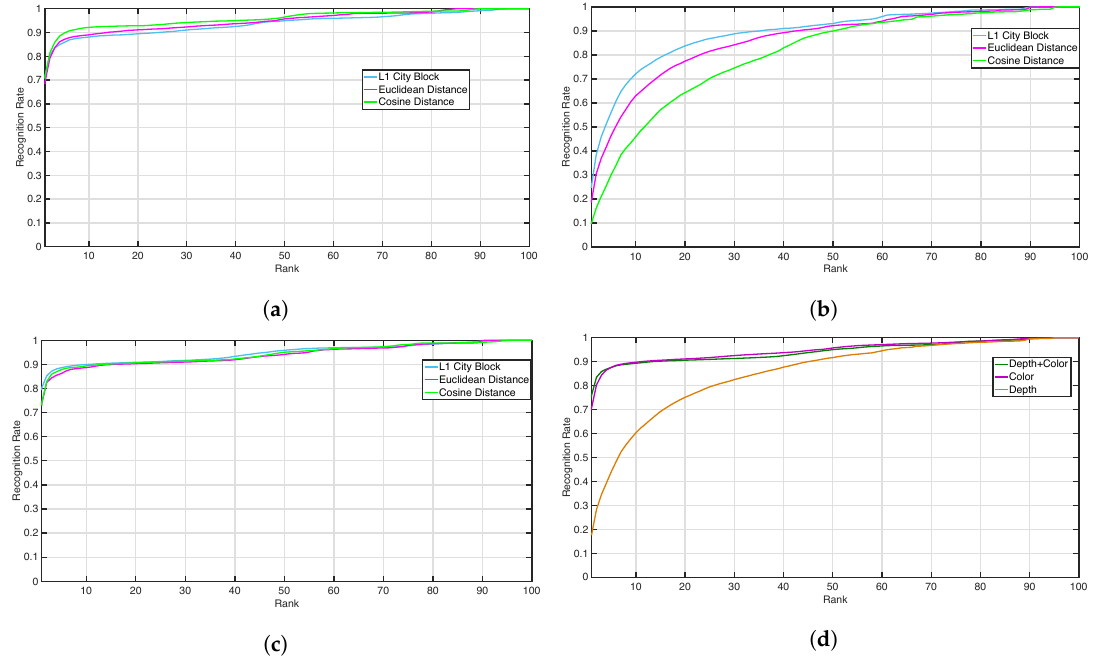
Figure 5. The baseline Cumulative Matching Curve (CMC) curves obtained on the Top View Person Re-Identification (TVPR) dataset. ( a , b ) shows respectively the CMC obtained using the TVH and TVD descriptors for three different distance: one-norm (L1 city block, cyan), two-norm (euclidean, purple) and cosine (green). ( c ) provides the CMC computed using both the TVH and TVD descriptors (i.e., TVDH ), while ( d ) is the averaged CMC over the three considered distance for the color (i.e., average of CMC curves in (a), purple), depth (i.e., average of CMC curves in (b), orange) and depth + color (i.e., average of CMC curves in (c),